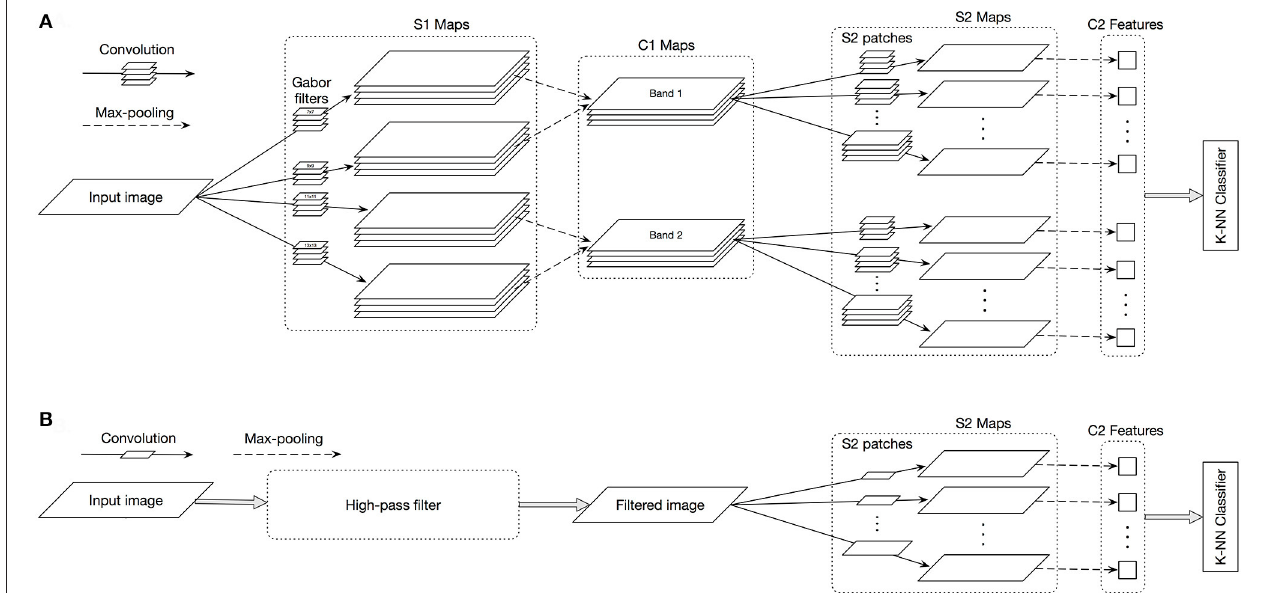
FIGURE 3 | (A) The overall sketch of Model I for processing the HSF bands. In the S1 layer, the input image is convolved with Gabor filters (four orientations) in the first four high spatial frequency sizes (i.e., HSF). C1 layer pools each of the two consecutive S1 maps. During the learning, S2 layer extracts patches of different size from the C1 output over different input images. During the test phase, the S2 patches are convolved with the output of the C1 layer. Then the C2 layer applies a global max operation over the output of each S2 output map. Finally a K-NN classifier detects the category of the input image based on the location of its C2 vector and nearest training C2 vectors. (B) The overall sketch of Model II for processing the HSF band. The input images are first filtered into the HSF band and then S2 patches are extracted from the filtered images. The remaining parts are similar to Model I. For both models, the same procedures but with different filters in first layers are used for the ISF and LSF